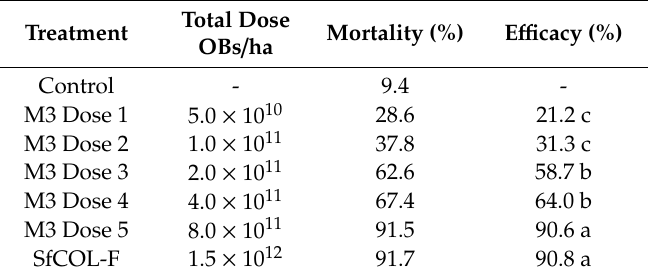
Table 5. Mortality of second-instar larvae of S. frugiperda under greenhouse conditions after the application of mixture M3 formulated as